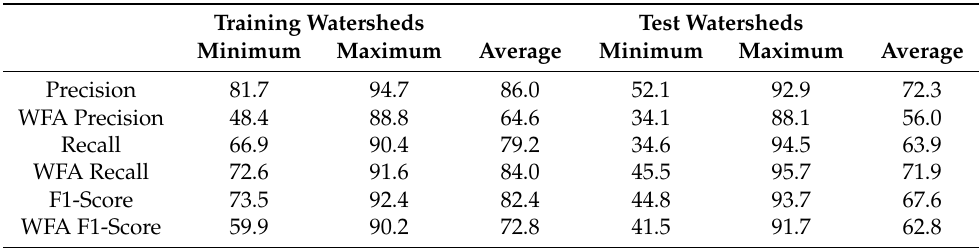
Figure 17. Accuracy values for the 14 training watersheds used in U-net model 14 compared to corresponding values resulting from U-net model 14 augmented with flow network features extracted from a D-8 flow accumulation model weighted with model 14 probabilities. Table 2. Summary statistics for precision, and F1-scores resulting from predictions for the 14 training and 36 test watersheds using U-net model 14 with comparison to corresponding values predicted from U-net model 14 augmented with flow network features extracted from a D-8 flow accumulation model weighted with model 14